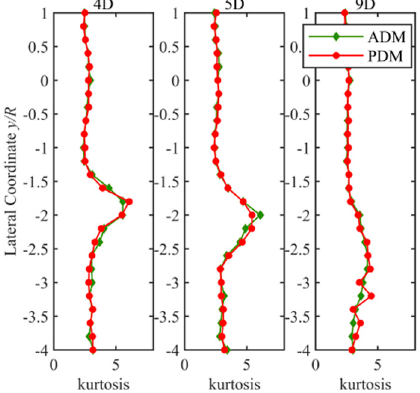
Figure 23. Kurtosis downstream in the ADM and PDM measured at hub height (ABL conditions).